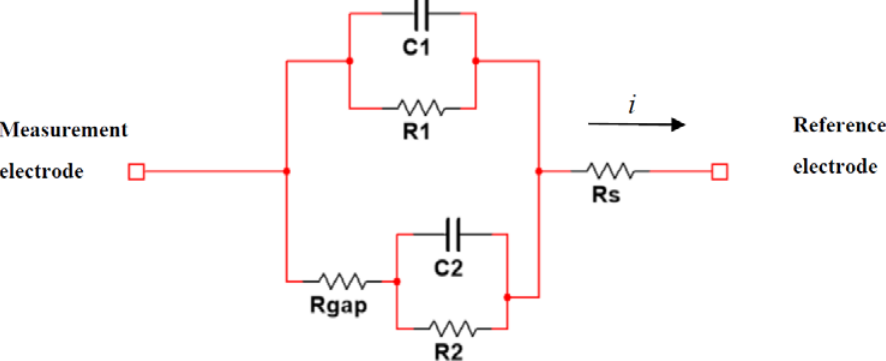
Figure 1. BioZ electric model.